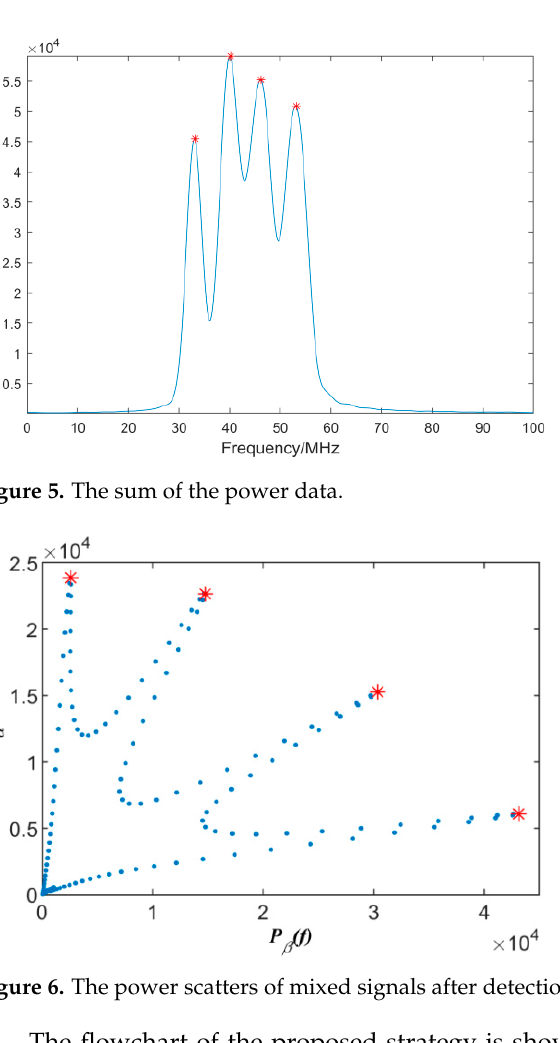
soft mask matrices can be constructed in this way.